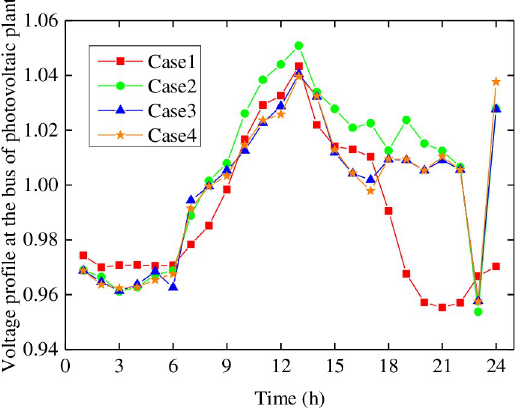
Fig 9. Voltage profiles at the bus of photovoltaic plant in different